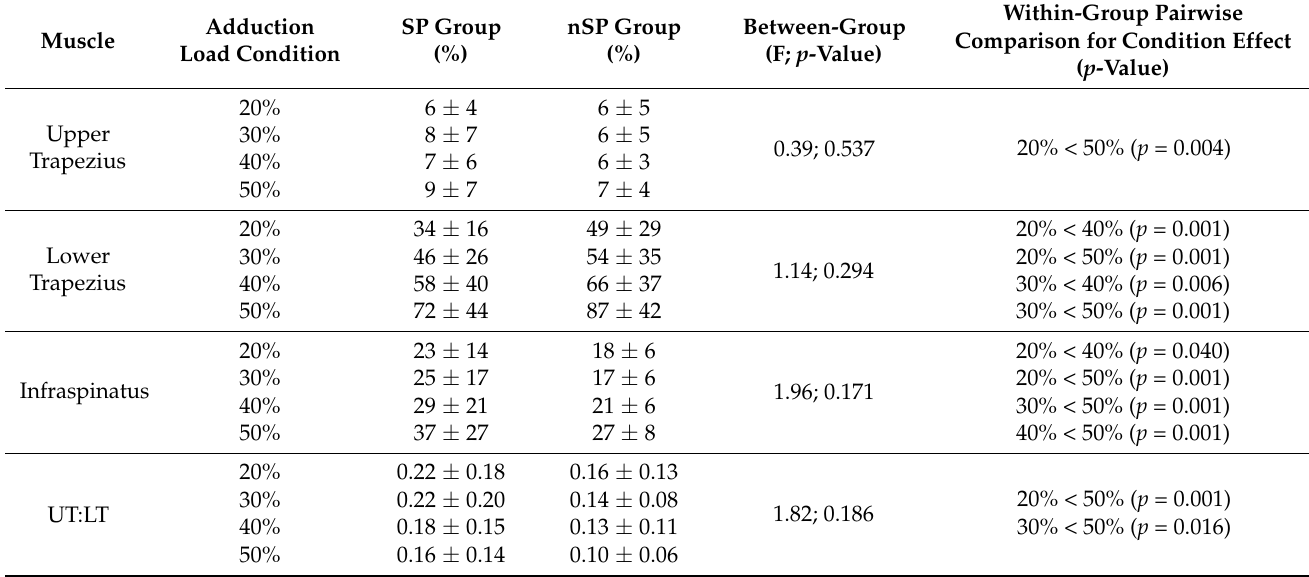
Table 2. Muscle excitation at different adduction loads (in % of the maximal voluntary isometric contraction using the load cell).